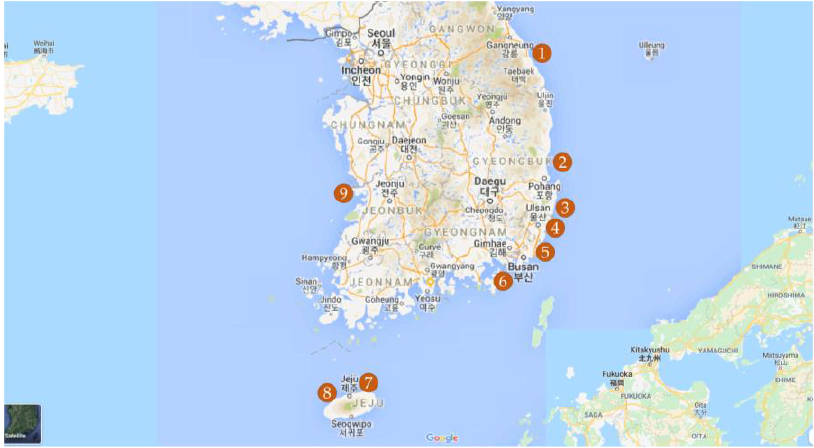
Figure 2. Locations of breakwaters considered in this study.